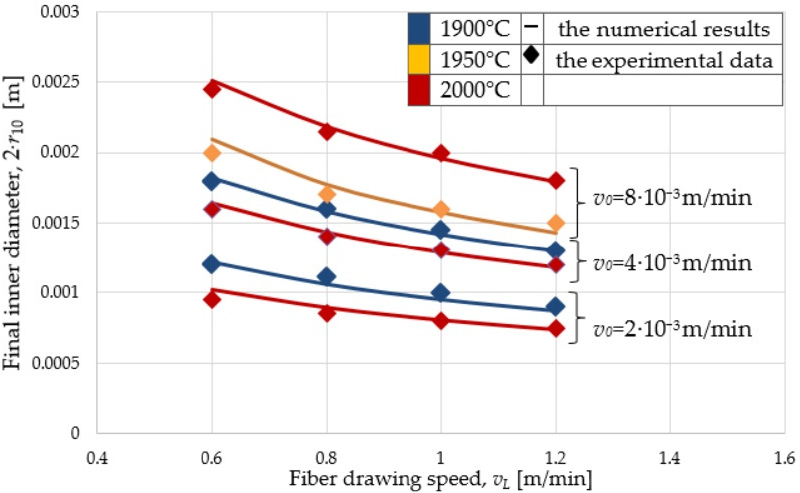
Figure 4. Dependence of the inner diameter of the capillary on the feed and draw speed, furnace temperature.